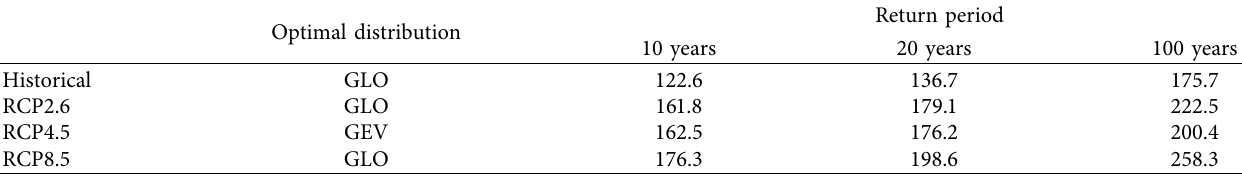
Table 12: Annual minimum monthly runof under three discharge scenarios and the historical period